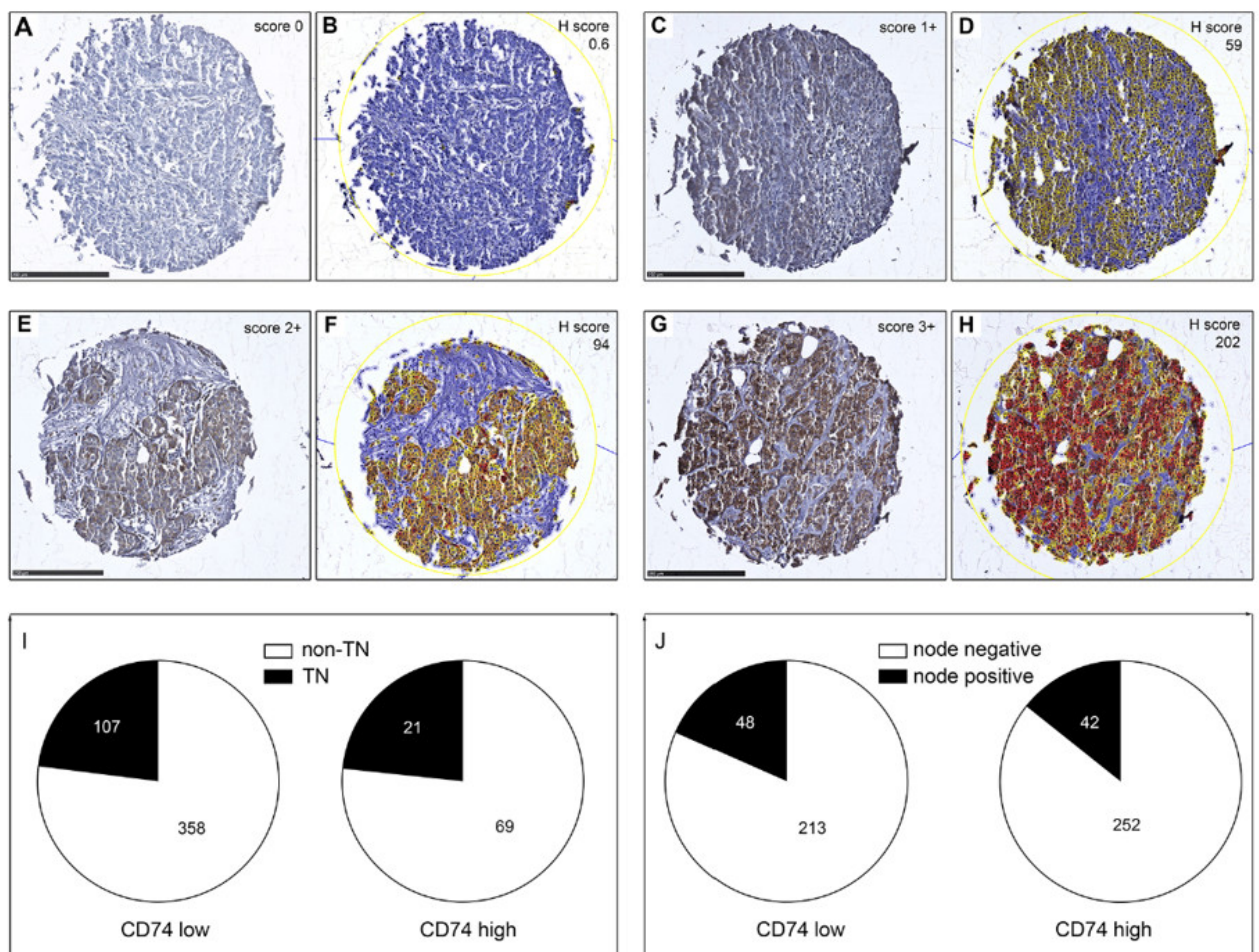
Figure 3. IHC analysis of YTMA49. TMA cores were scored in a categorical manner according to CD74 immunoreactivity levels in tumor cells only, as follows: 0 (absent), 1+ (weak), 2+ (moderate) or 3+ (strong) (( A , C , E , G ), respectively). An H-score value was also derived by computer-assisted whole tissue core analysis ( B , D , F , H ). Negative, weak, moderate and strong immunostaining thresholds are yellow, orange, and red, respectively. Intensity scores were correlated to ( I ) TN status and ( J ) node status. Scale bars = 250 µm.